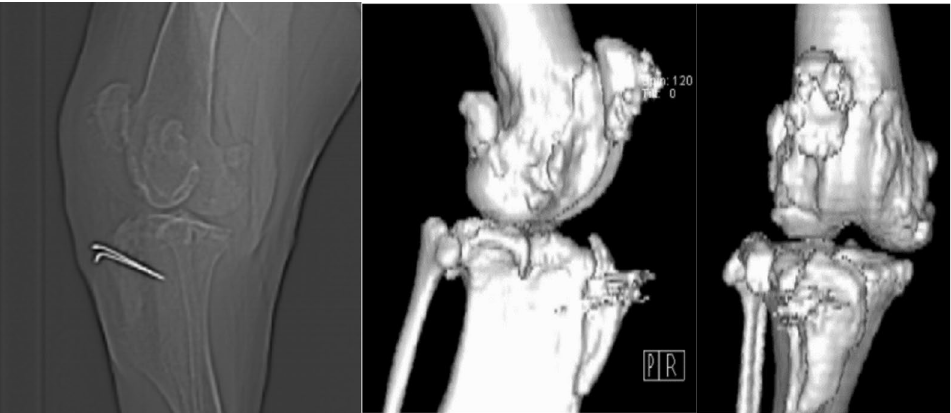
Figure 1. Preoperative CT views of the dog. There is contact between femur and patella. Patella could luxate easily to the lateral side of the